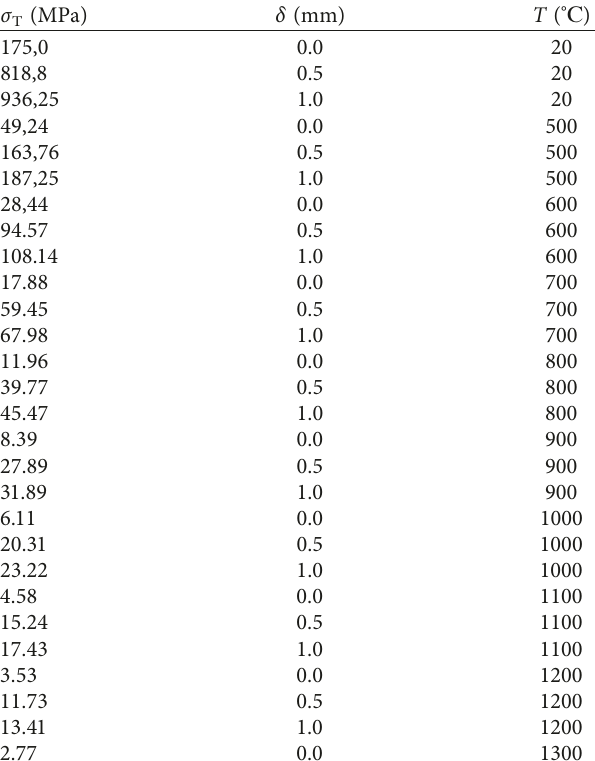
Table 4: Yield strength σ T depending on plastic deformation δ and heating temperature T